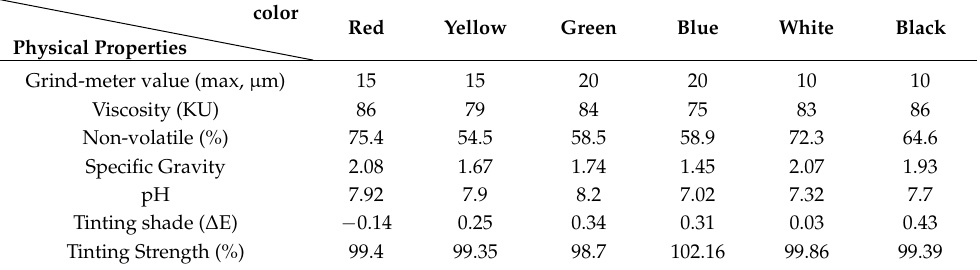
Table 2. The physical properties of inorganic color paste.